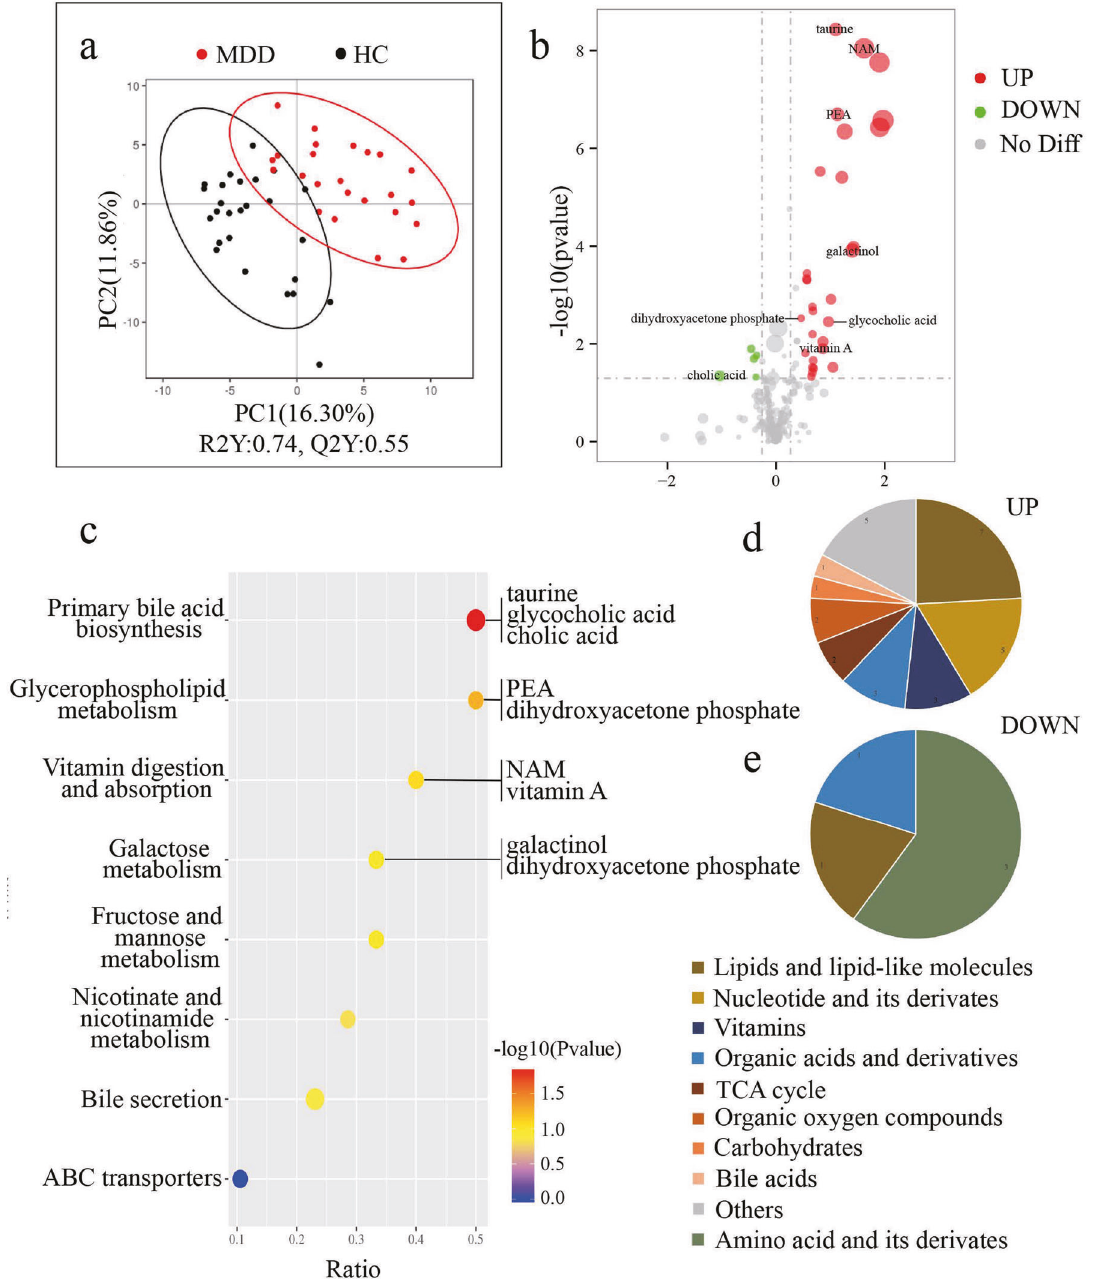
Fig. 3 Metabolites showing a signi fi cant difference between MDD and HCs. a Partial least squares discriminant analysis (PLS-DA) establishes the model by partial least square regression showing clear discrimination between MDD and HCs. b The volcanic map shows 34 signi fi cantly different metabolites. Red dots represent increased metabolites; while green dots indicate decreased metabolites. The size of the dot represents the Variable Importance for the Projection (VIP). Vertical coordinate shows levels of signi fi cance. c The bubble chart shows KEGG pathways between two groups, which excludes the pathway which annotates only one metabolite. The size of the dot represents the number of metabolites in the pathway. The red dots are more signi fi cant than the blue dots. The metabolites of the top three pathways were labeled both in fi gs. b and c . d – e A total of 29 increased metabolites in the MDD group are arranged on the left, while 5 downregulated metabolites are arranged on the right. Most of the upregulated metabolites belong to lipids and lipid-like molecules (24.14%), nucleotide and its derivates (17.24%), vitamins (10.34%), and organic acids and derivatives (10.34%); while downregulated metabolites mainly belong to amino acid and its derivatives (60.00%).NAM Nicotinamide, PEA P-value were the primary bile acid biosynthesis, glyceropho- (1/5, 20.00%) and organic acids and derivatives (1/5, 20.00%) were spholipid metabolism, vitamin digestion and absorption, and the metabolites decreased in the MDD group (Fig. 3(e)). galactose metabolism. They are mainly involved in lipid, vitamin, We identi fi ed forty discernible KEGG pathways between the two and carbohydrate metabolism. The differential metabolites partici- groups. The result excluding the pathway which annotates only one pating in the four pathways have been labeled in Fig. 3 (b) and (e), metabolite was shown in Fig. 3(c). The top four pathways based on